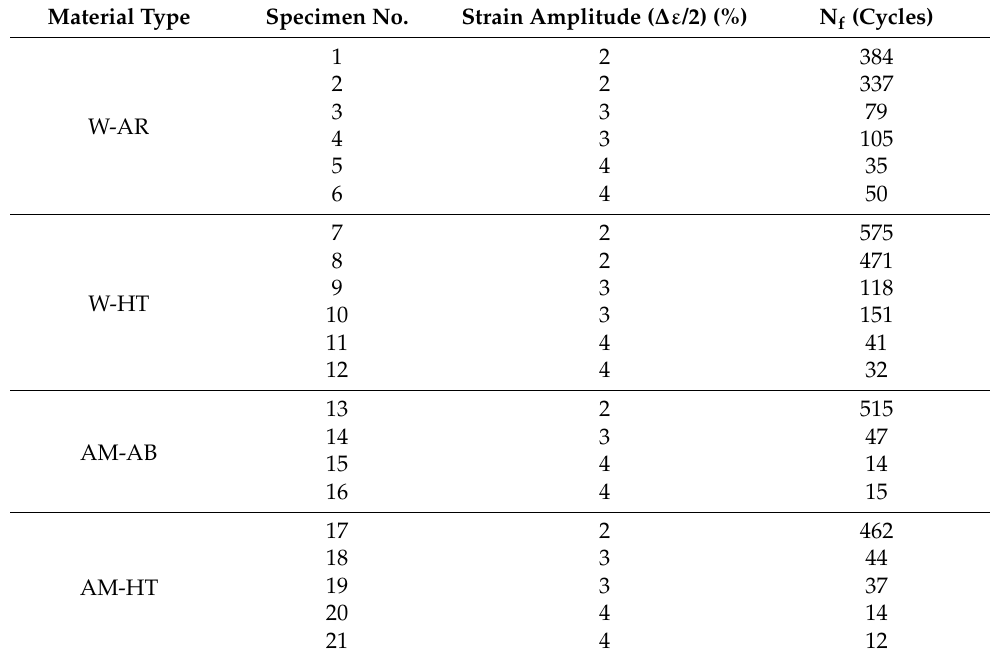
Table 3. Ultra low-cycle fatigue test